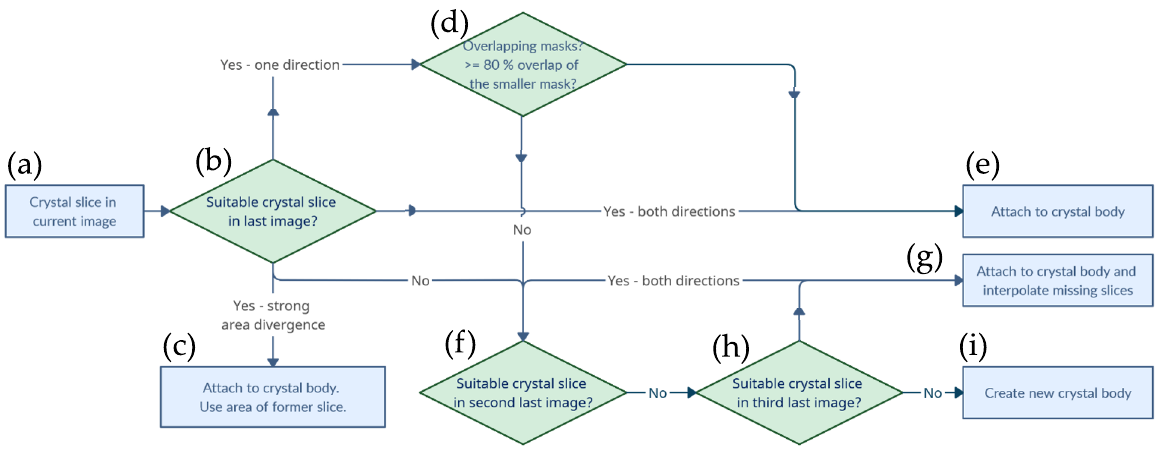
Figure 4. Visualization of the algorithm responsible for the reconstruction of the segments detected on each slice into individual volumes. From the particle in the current slice ( a ), the next and previous slices were looked at to determine whether a similar particle shape occurred ( b ) and if so the current particle was attached to the existing particle body ( d , e ) Otherwise, in the case of a strong area divergence, the contour of the previous slice was recycled ( c ) or missing slices interpolated ( g ), or it marked the beginning of a new particle ( f , h , i